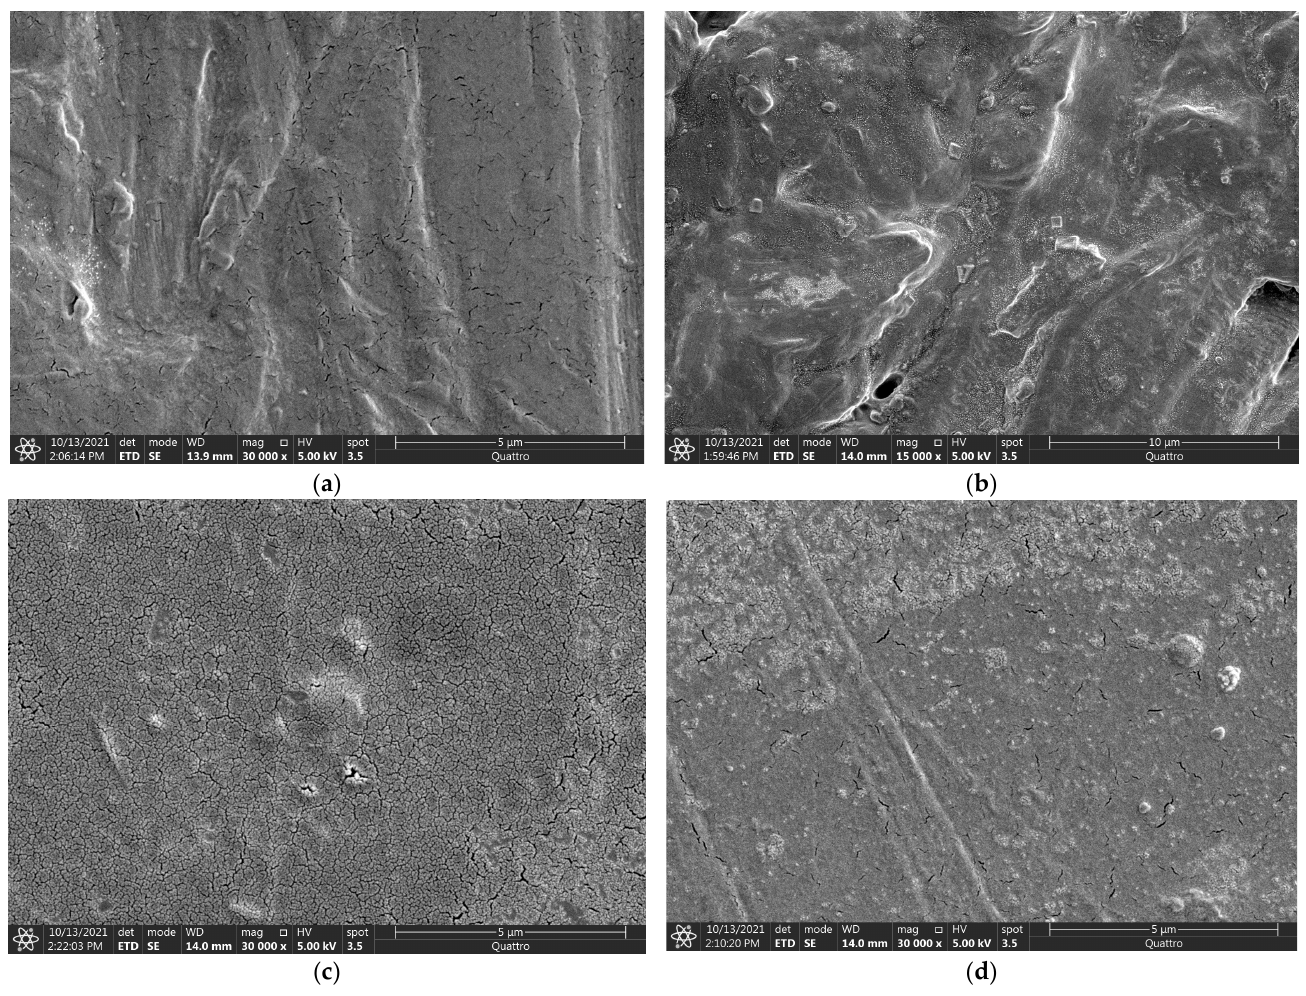
Figure 3. Scanning electron microscopy of wood composite samples at × 30,000 magnification for the ( a ) HDPE-control sample, ( b ) HDPE-18 wt. % wood sample, ( c ) PP-control sample, and ( d ) PP-18 wt. % wood sample.